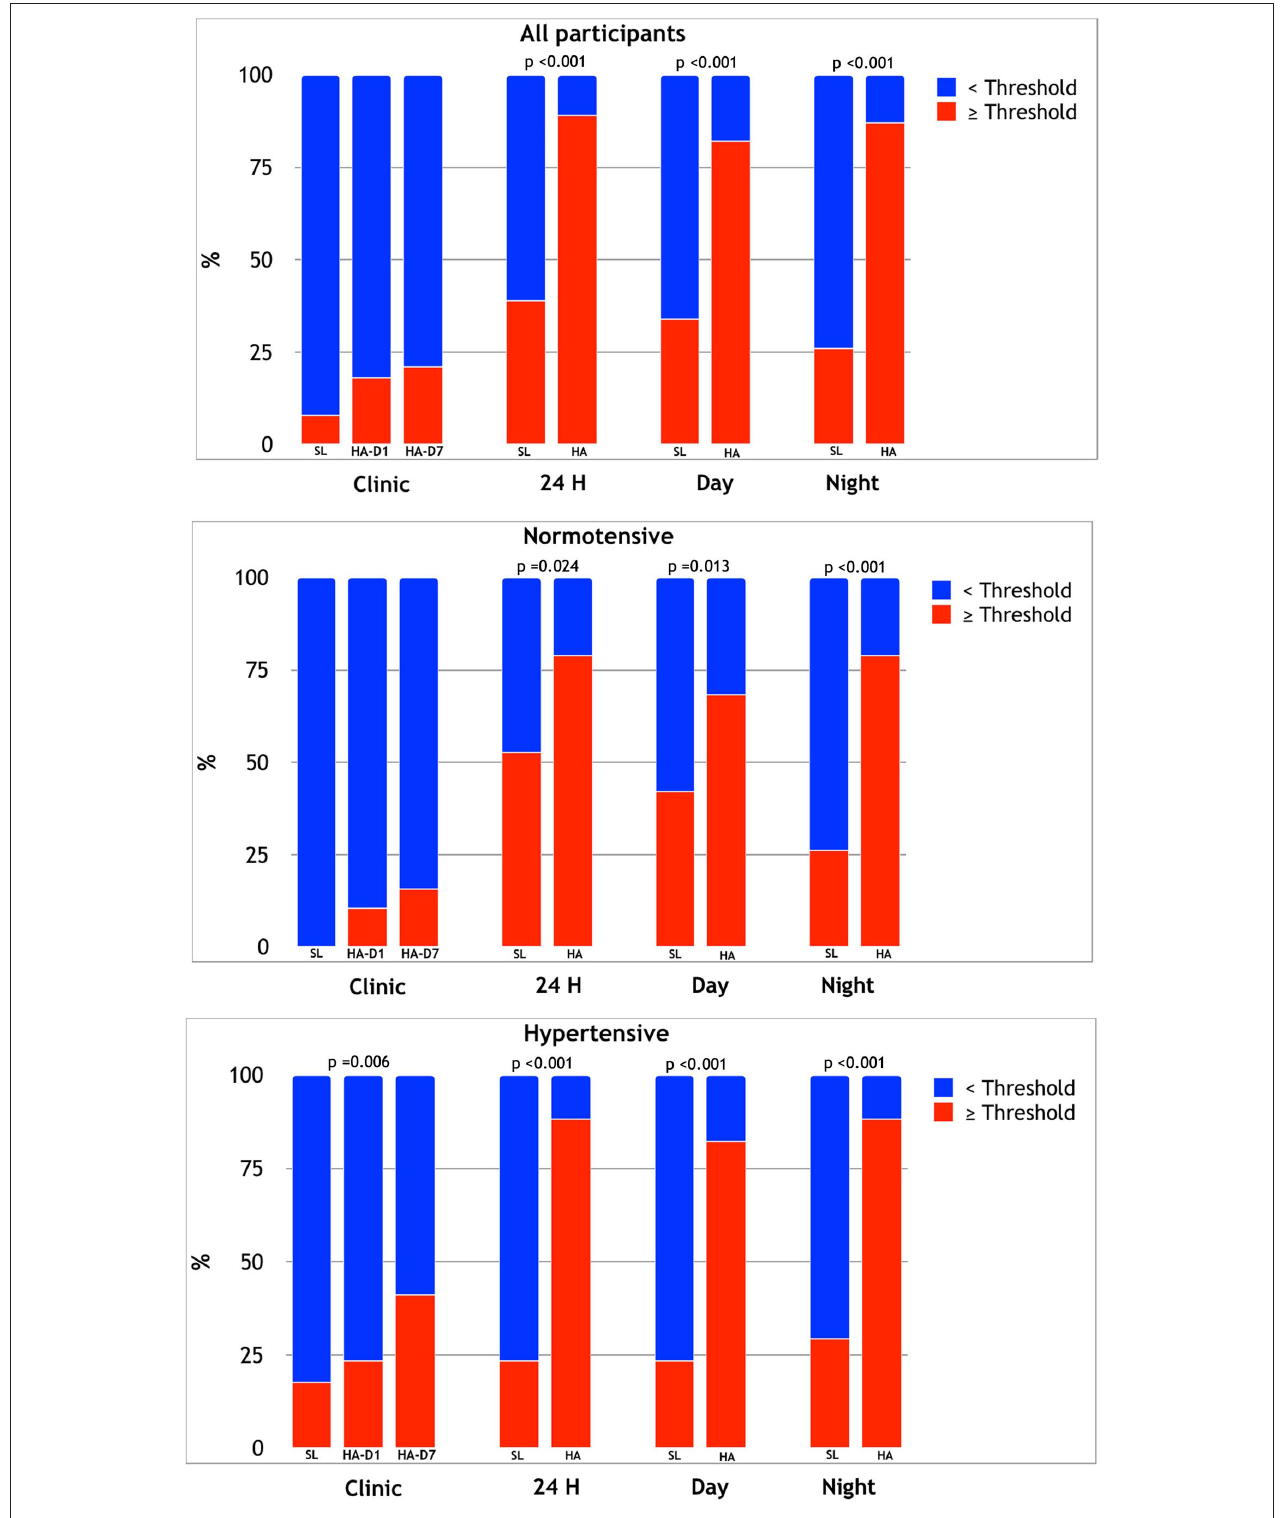
FIGURE 2 | Relative prevalence of participants exceeding clinic, mean 24-h, daytime, and night HT threshold at SL and HA in the overall sample (upper panel), in NT (middle panel), and HT (lower panel) subjects.